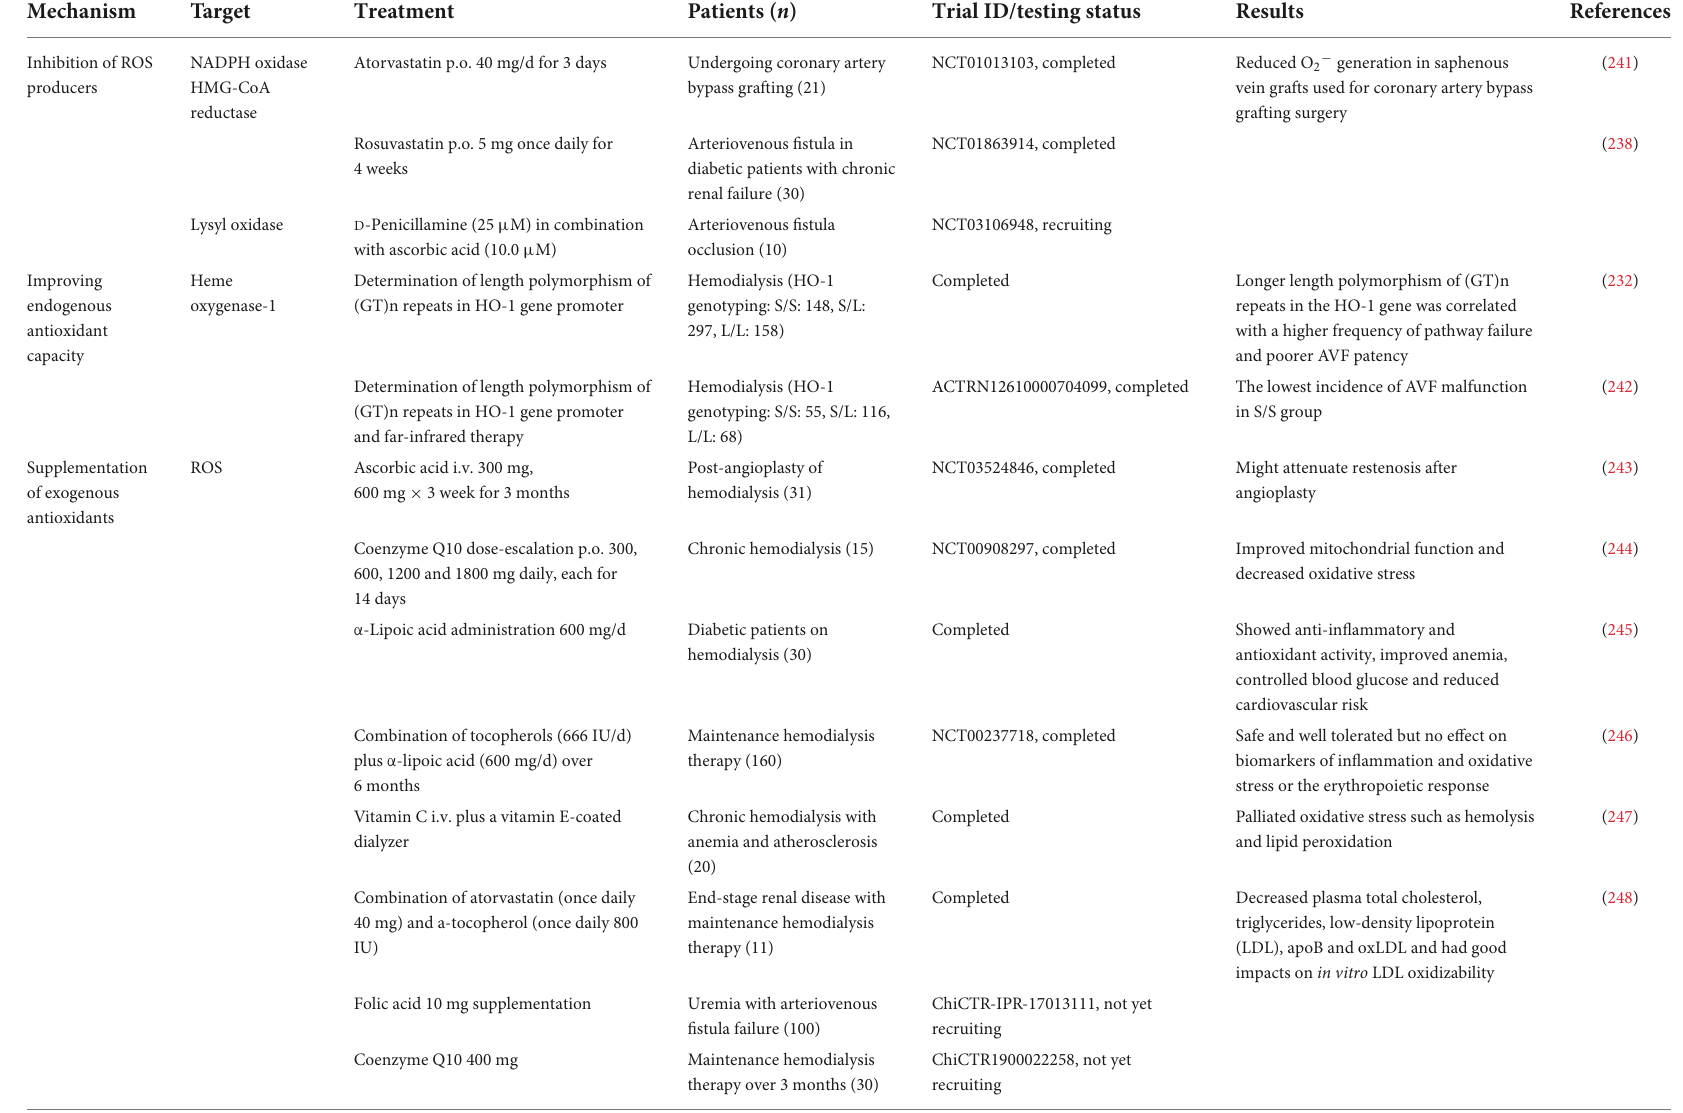
TABLE 2 Antioxidant therapies in AVF